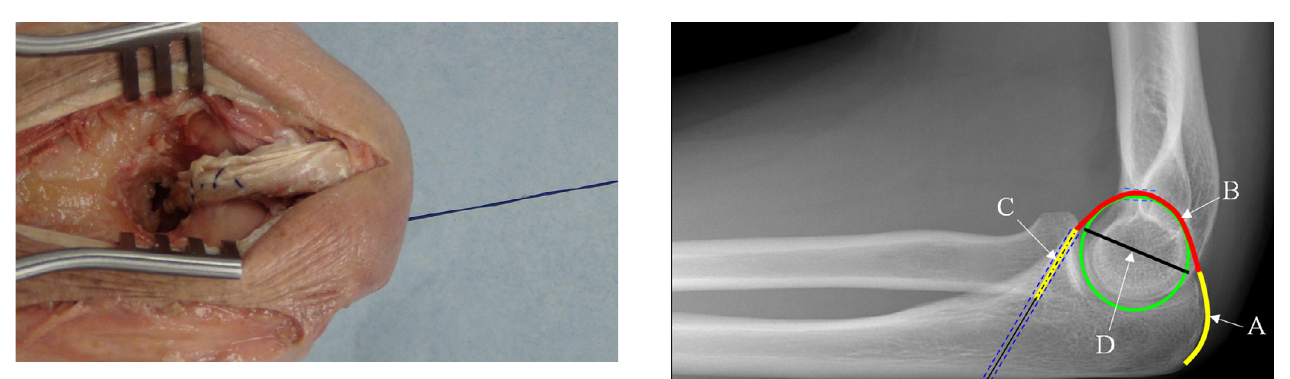
Figure 5. Posterior view of the graft in its final position.